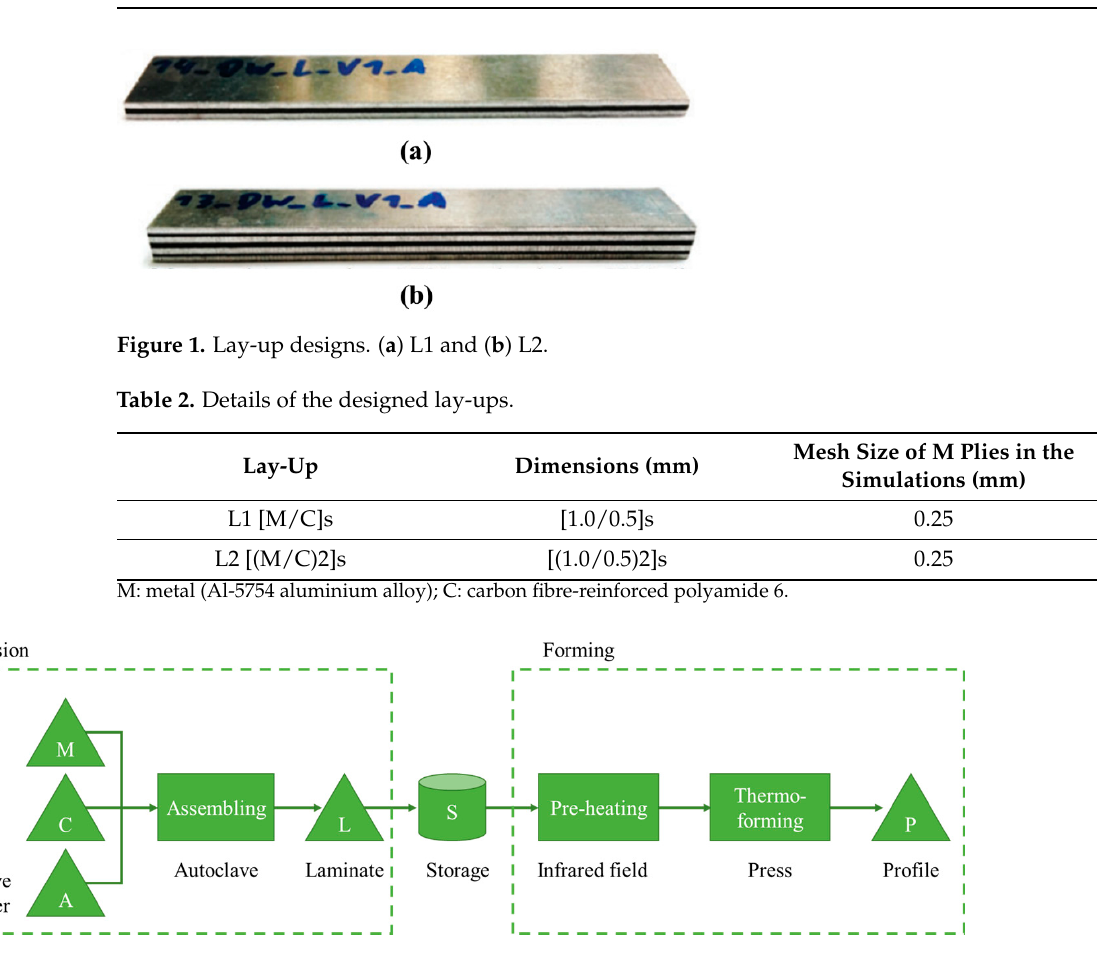
Figure 2. Conceptual flowchart of the adhesion and forming process.